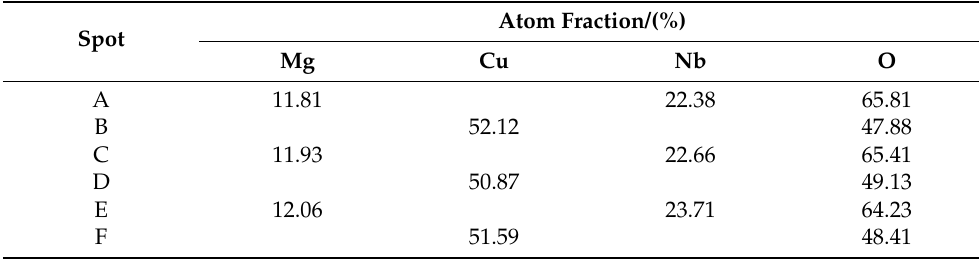
Table 2. The EDS results of MgCu 2 Nb 2 O 8 ceramics corresponding to the abnormal grains. Atom Fraction/(%) Spot Mg Cu